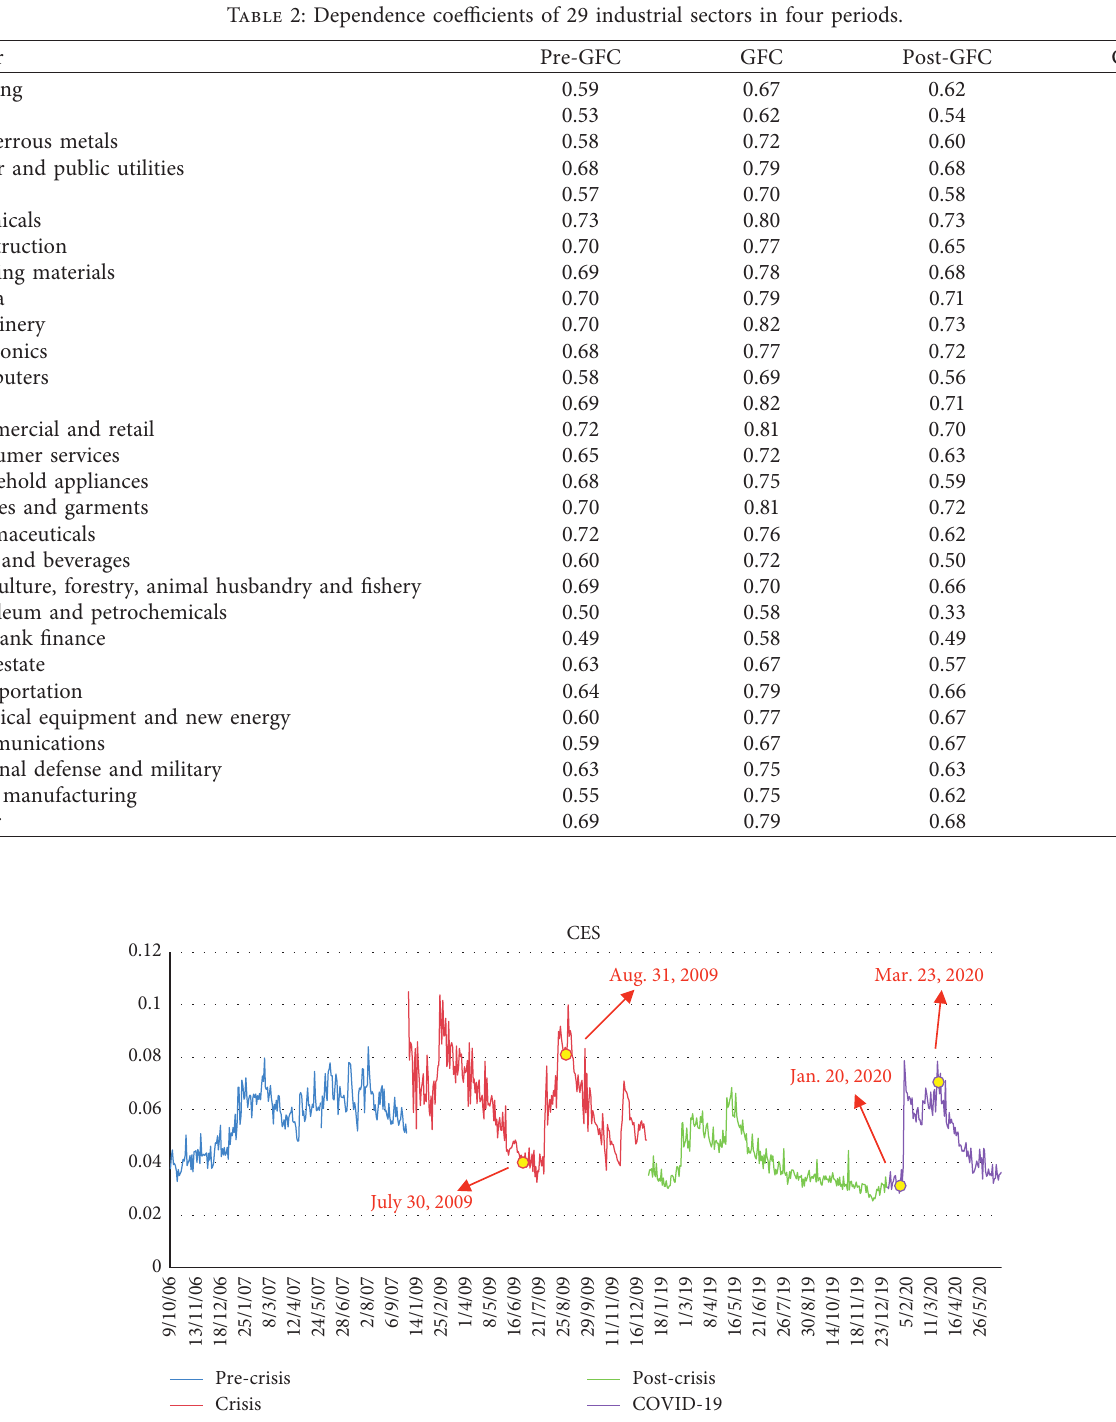
Figure 3: CES in four periods.